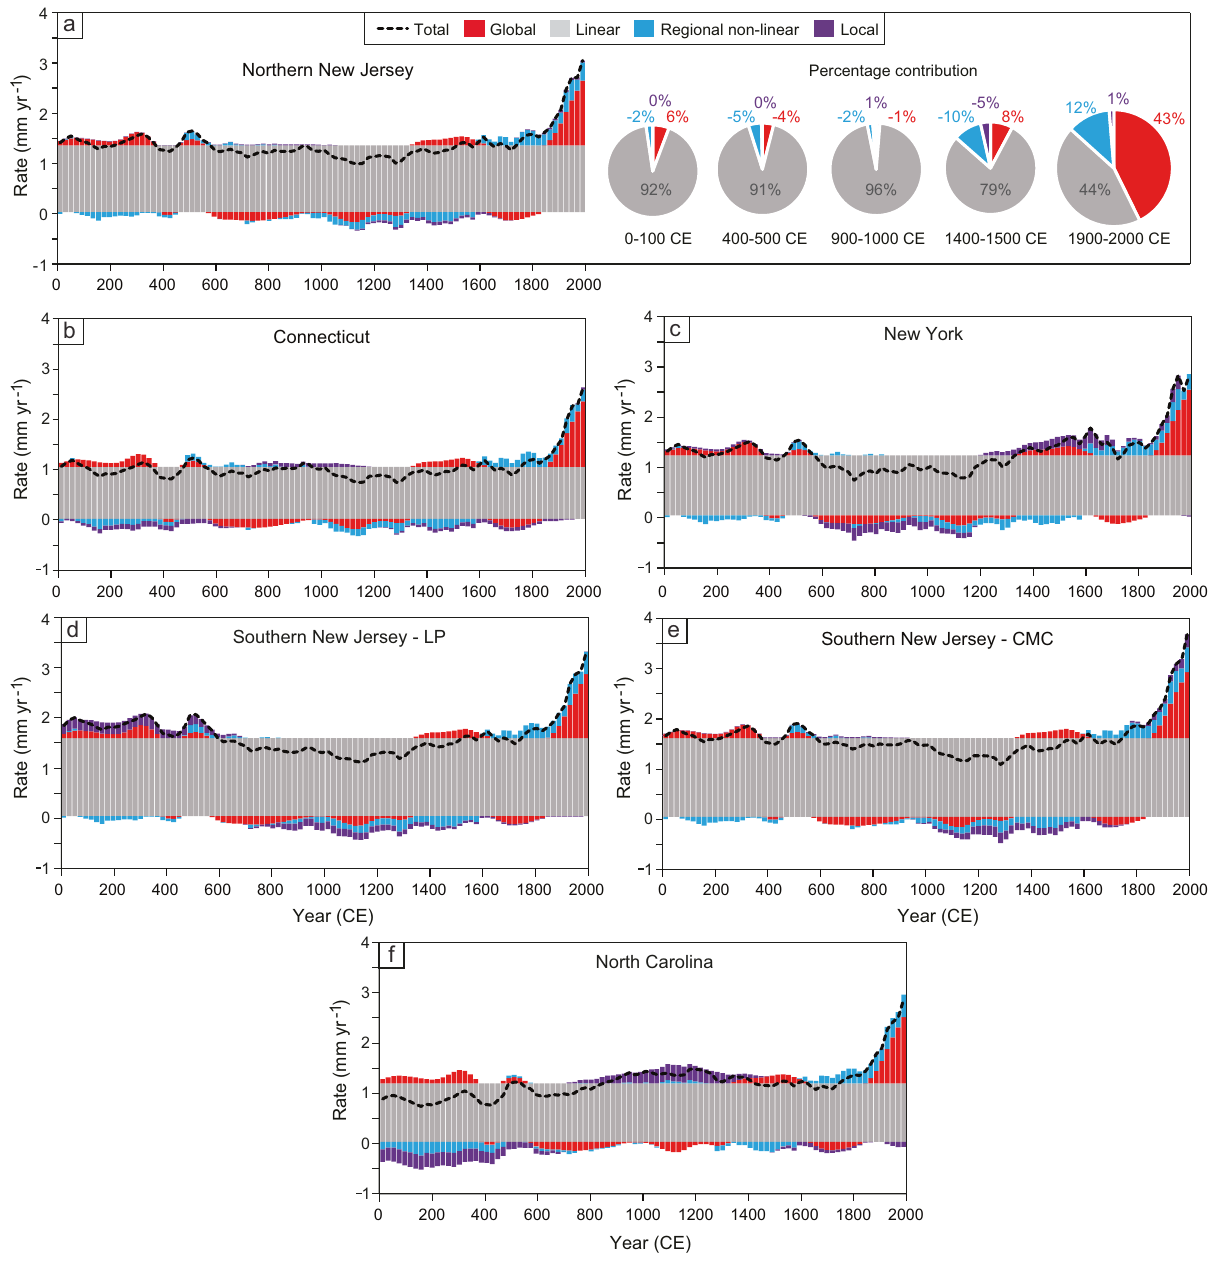
Fig. 4 Common Era sea-level budgets. Budgets are separated into global, linear, regional nonlinear, and local components for a northern New Jersey; b Connecticut; c New York; d southern New Jersey — Leeds Point (LP); e southern New Jersey — Cape May Courthouse (CMC); f North Carolina. Total rates for each site are indicated by dashed black line. Percentage contributions of each budget component are also shown for northern New Jersey for fi ve 100- year time intervals through the Common